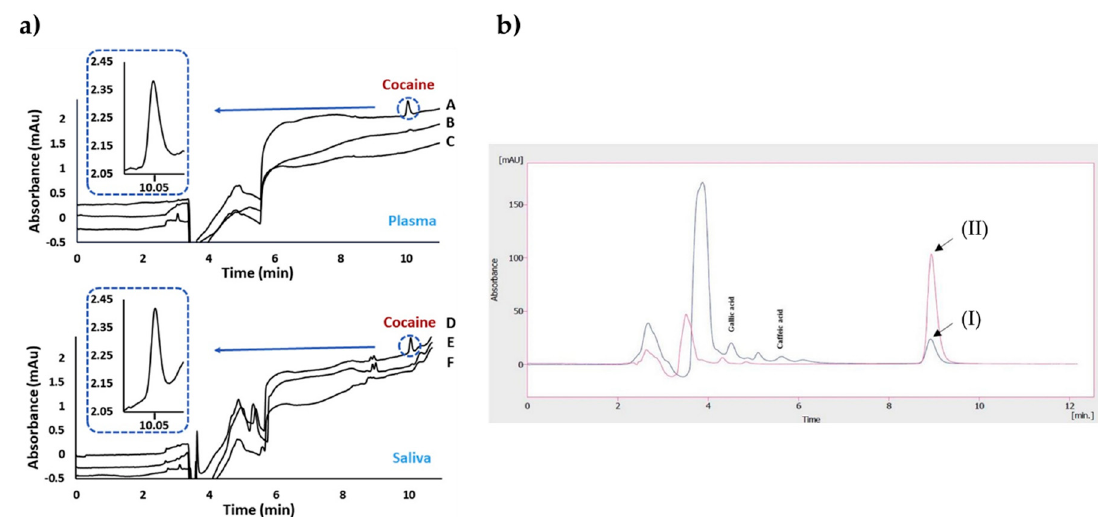
Figure 2. Chromatograms after the extraction of cocaine on plasma and saliva samples ( a ). The indicators in the plot: imprinted (A) and non-imprinted (B) of plasma spiked with cocaine compared to the blank plasma (C); imprinted (D) and non-imprinted (E) of saliva spiked with cocaine compared to the blank saliva (F). Chromatograms before and after extraction of real black tea samples ( b ). The indicators in the plot: unspiked black tea sample before (I) and after (II) extraction. Republished with permission from Bouvarel et al. and Rahimi et al. [71,72]. Table 2. Comparison of molecularly imprinted chromatographic systems.